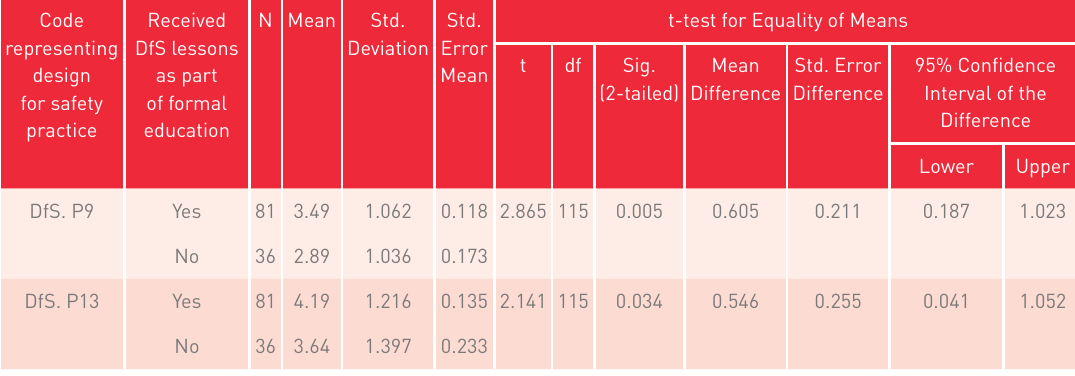
Independent samples t-test based on receipt of DfS lessons as part of formal education.